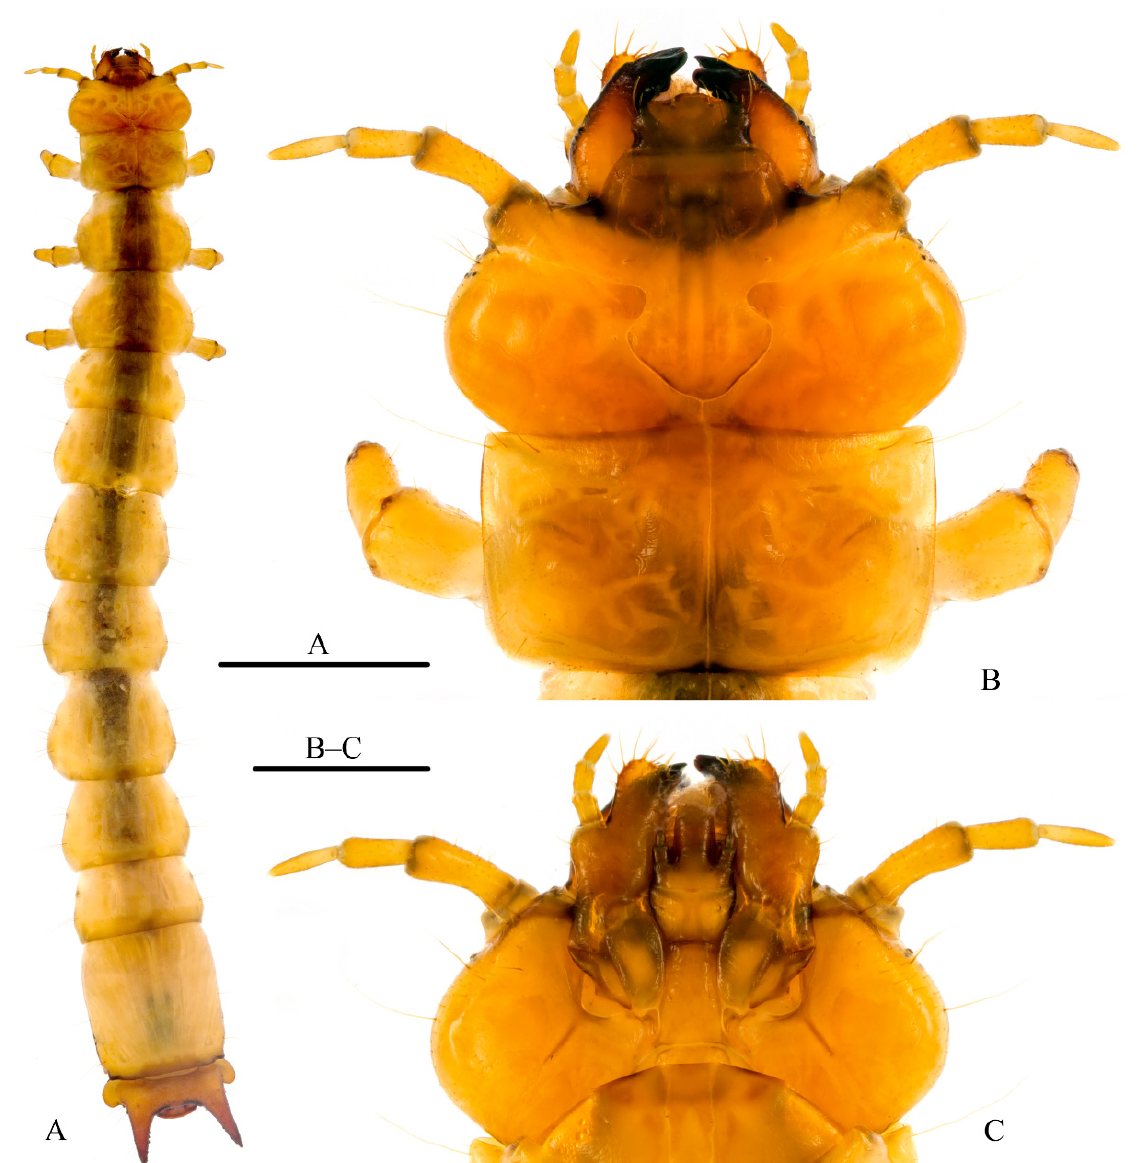
Figure 4. Larva of Pseudopyrochroa reni Pan & Young, n. sp. ( A ) Habitus, dorsal view; ( B ) Head and pronotum, dorsal view; ( C ) Head, ventral view. Scale bars: 5 mm ( A ), 1 mm ( B , C ). Head (Figures 4B,C): Prognathous, flattened, exserted from prothorax. Epicranial su- ture (Figure 4B) lyriform with stem short, frontal arms complete nearly to antennal inser- tions; endocarinae absent. Free, symmetrical labrum anteriad fused frontoclypeal region. Four stemmata on each side, in 2 groups of 2, lower pair parallel with antennal insertions. Antennal insertions fully exposed, antennae (Figures 4B,C) moderately elongate, filiform, 3-segmented, antennomere I 0.2–0.3 longer than antennomeres II and III; sensorium of II small, conical; III narrower than antennomeres I–II, acutely rounded apically. Mouthparts retracted. Mandibles (Figure 4B) heavily sclerotized, asymmetrical, molar area of each mandible well developed, left mandible bearing a prominent molar tooth; apex of right mandible distinctly tridentate, that of left mandible bidentate; dorsal mandibular surface basad molae with microtrichial complex well developed. Maxillae (Figure 4C) each with 1-segmented cardo diagonally folded upward upon itself toward stipes and thus appear- ing 2-segmented, and a well-developed, undivided, pad-like maxillary articulating area;